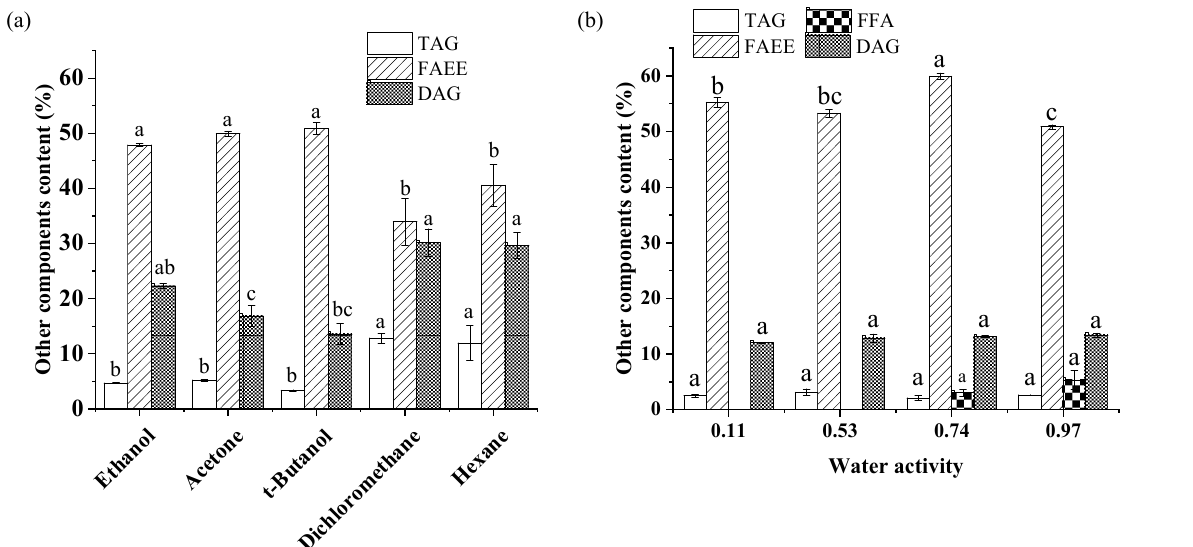
Figure 5. Effect of solvent type ( a ) and a w ( b ) on the contents of other lipid components in the crude product. Reaction conditions: ( a ) molar ratio of 1:40 (fungal oil/ethanol), 15% (relative to the mass of oil) Lipozyme TL IM, solvent volume of 1 mL, a w of 0.53, 35 °C, 8 h; ( b ) molar ratio of 1:40 (fungal oil/ethanol), 15% (relative to the mass of oil) Lipozyme TL IM, 3 mL t -butanol as solvent, 35 °C, 8 h. Different letters in the figure indicated significant differences at the p < 0.05 level.